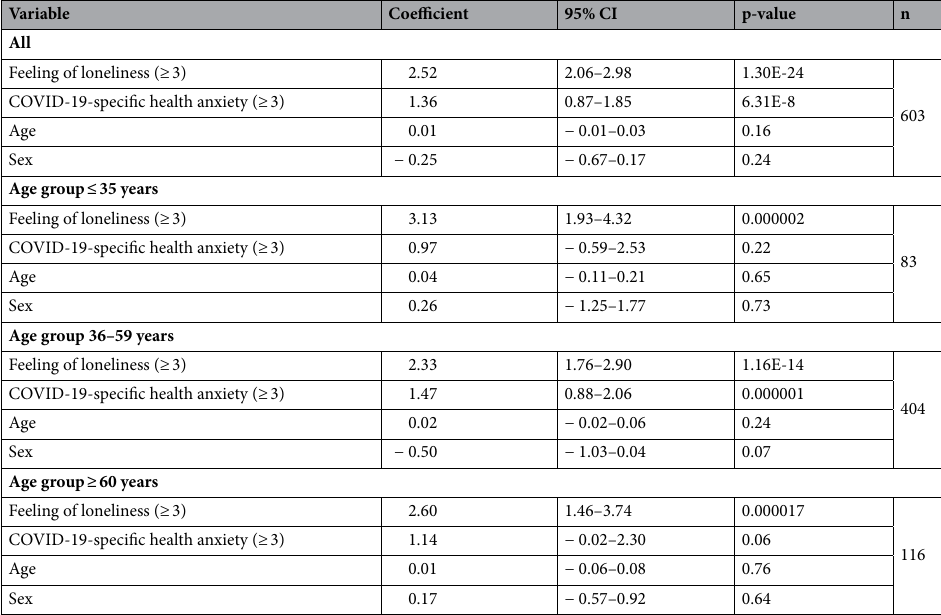
Table 2. Multivariable regression analysis stratified by age groups. Dependent variable: BDI-FS score during COVID-19 pandemic. Sex is coded as follows: 0 = male/1 = female. Level of significance is adjusted following Bonferroni correction p < 0.0125. A multivariable logistic regression analysis with the relevant dependent variable depression, defined as BDI-FS ≥ 4 points, and the above used independent variable was